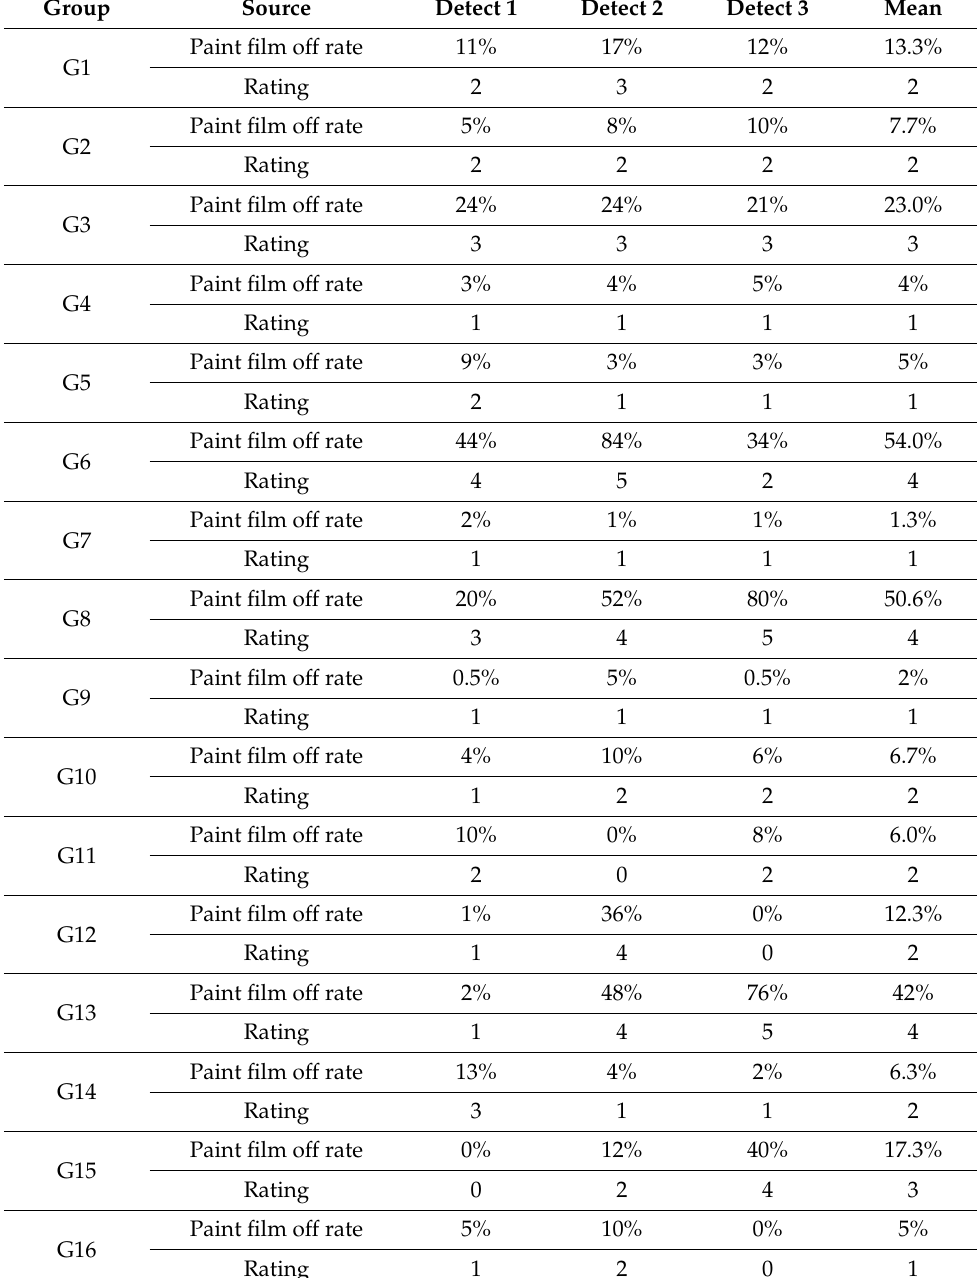
Table 7. The measured value of adhesion of paint film.